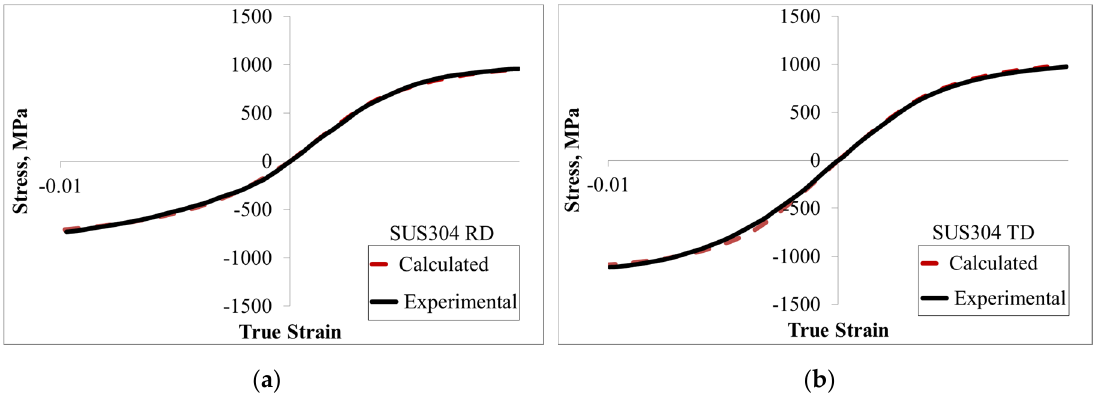
Figure 6. Experimental and fitted true stress and strain in tension and compression in the ( a ) rolling direction and ( b ) transverse direction. Table 4. Material parameters used in the analytical method.